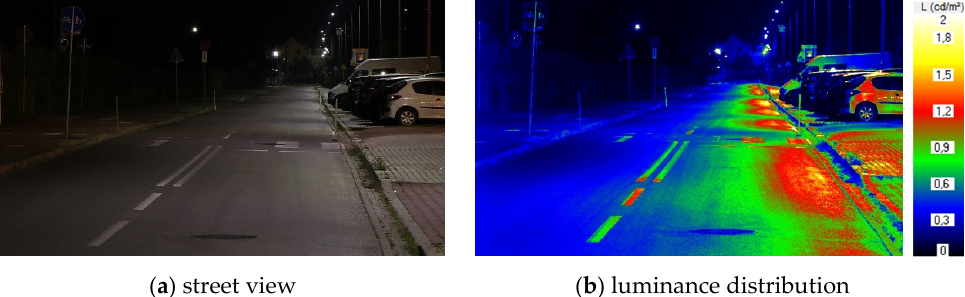
Figure 18. View of the street with lighting when the luminous flux Φ of the lamps is controlled to 91% (average luminance of the roadway is Lav = 0.68 cd/m 2 ).